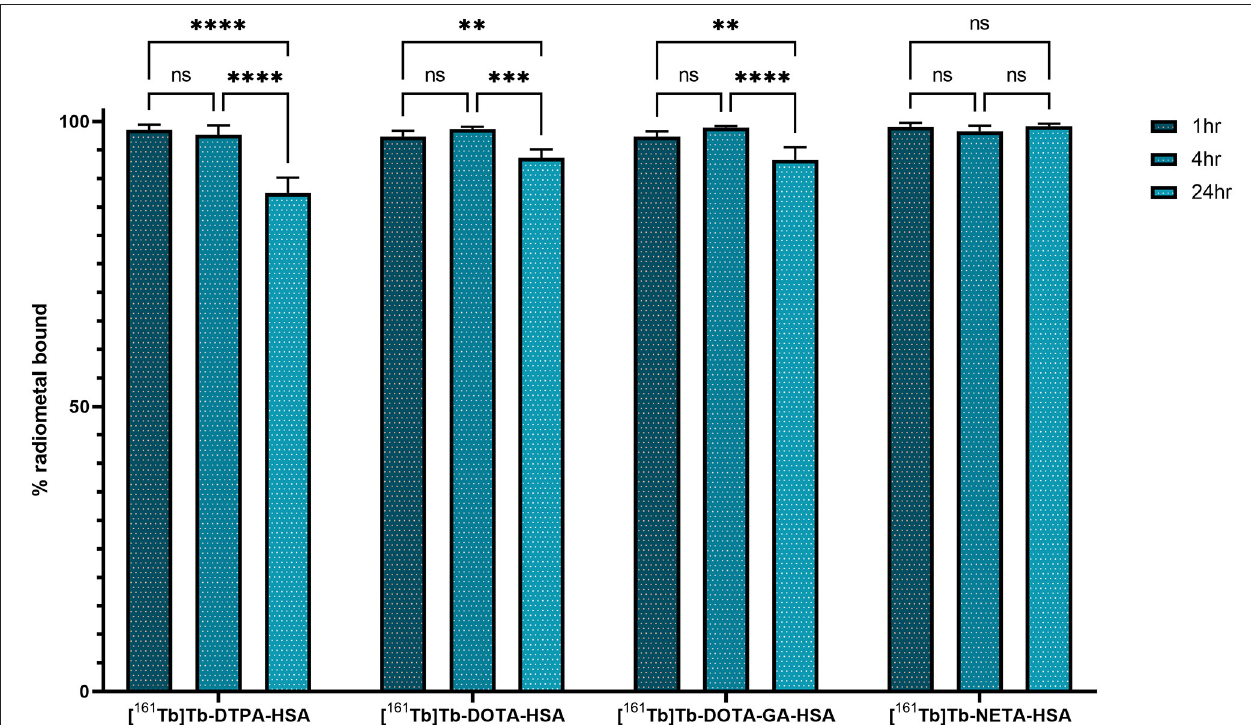
FIGURE 4 | In vitro stability of 161 Tb-radiolabeled HSA-complexes in human serum at 37 ◦ C. Significant values are expressed as P < *0.05, **0.01, ***0.001, ****0.0001.